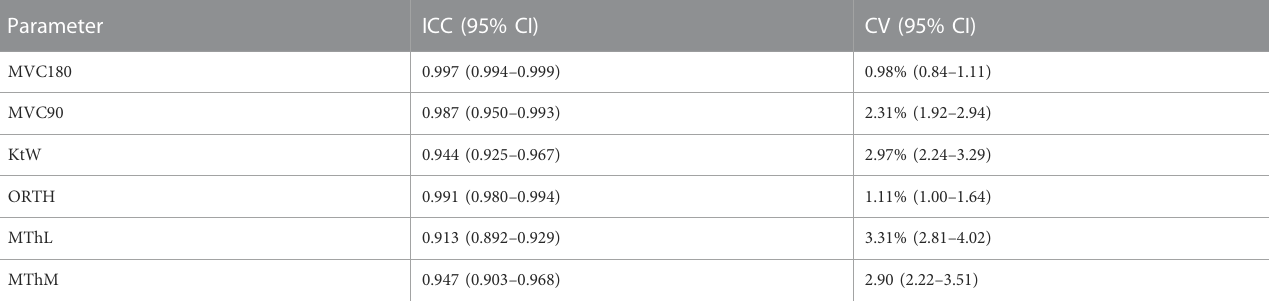
TABLE 1 Intraclass correlations coef fi cients (ICC) and the coef fi cient of variability (CV) are stated to determine the reliability of included tests.